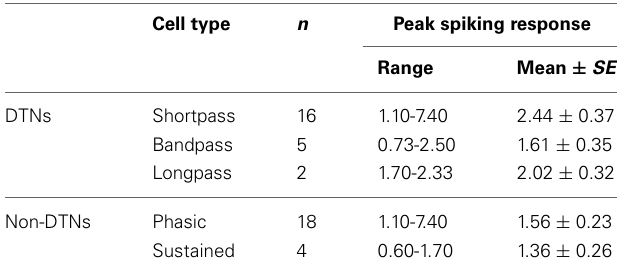
Table 5 | Range and average peak spike counts (spikes per stimulus) for cells tested with ITD stimuli at + 10dB above threshold.